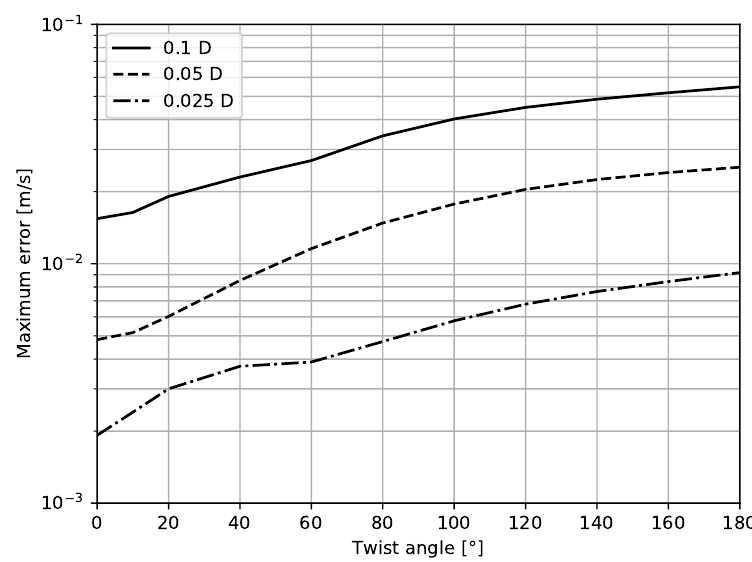
Figure 9. Maximum error of the axial flow velocity for different twisting angles. Results are shown for the three different mesh densities.